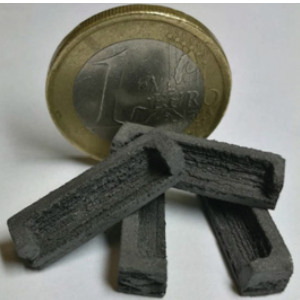
Figure 4. Image of the printed Neofer (cid:1) 25/60p